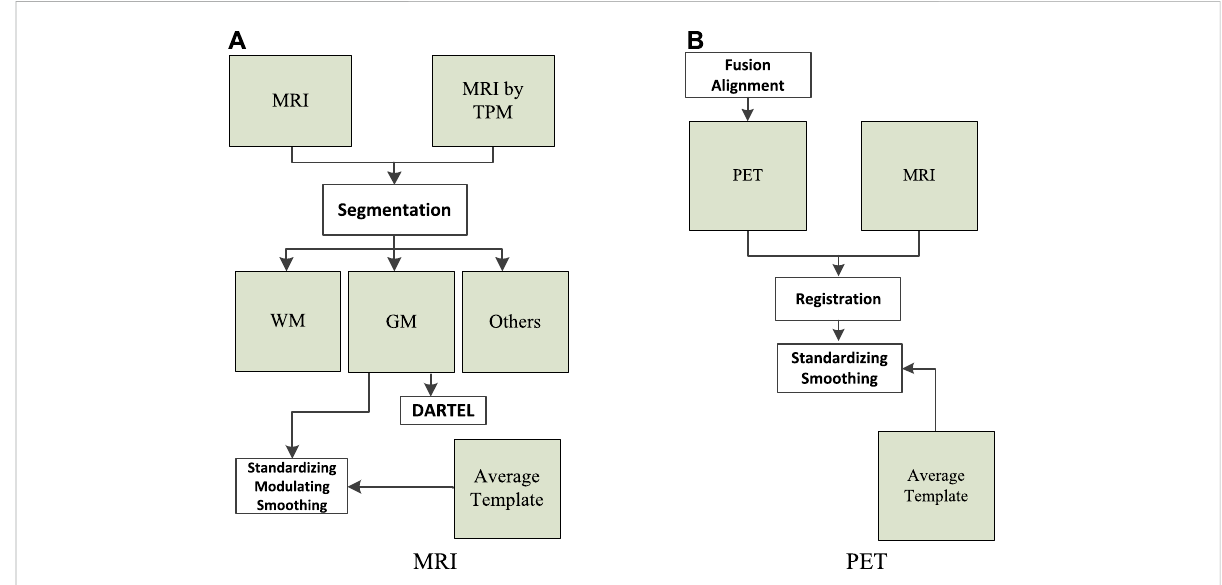
FIGURE 1 Data preprocessing: (A) magnetic resonance imaging (MRI) and (B) positron emission tomography (PET).